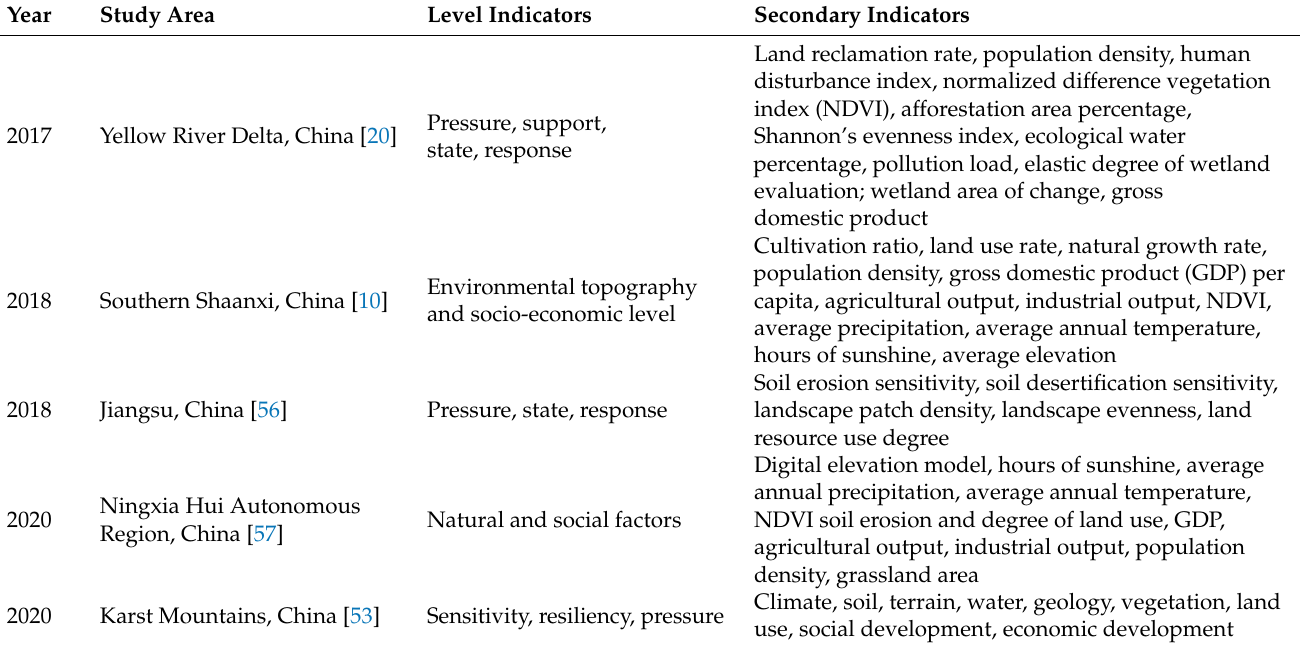
Table 2. Different ecosystem vulnerability assessment